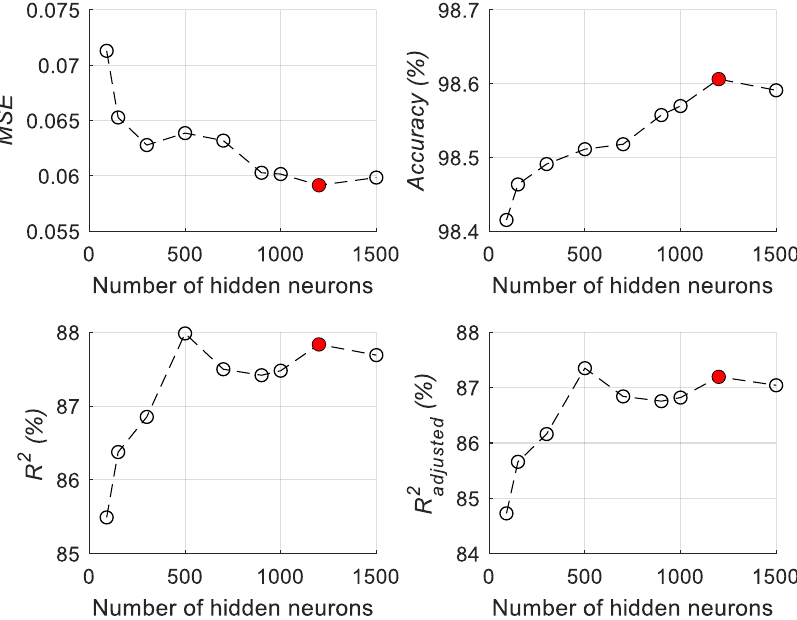
Figure 5. The influence of the number of hidden neurons on the prediction performance of the extreme learning machine (ELM) model.